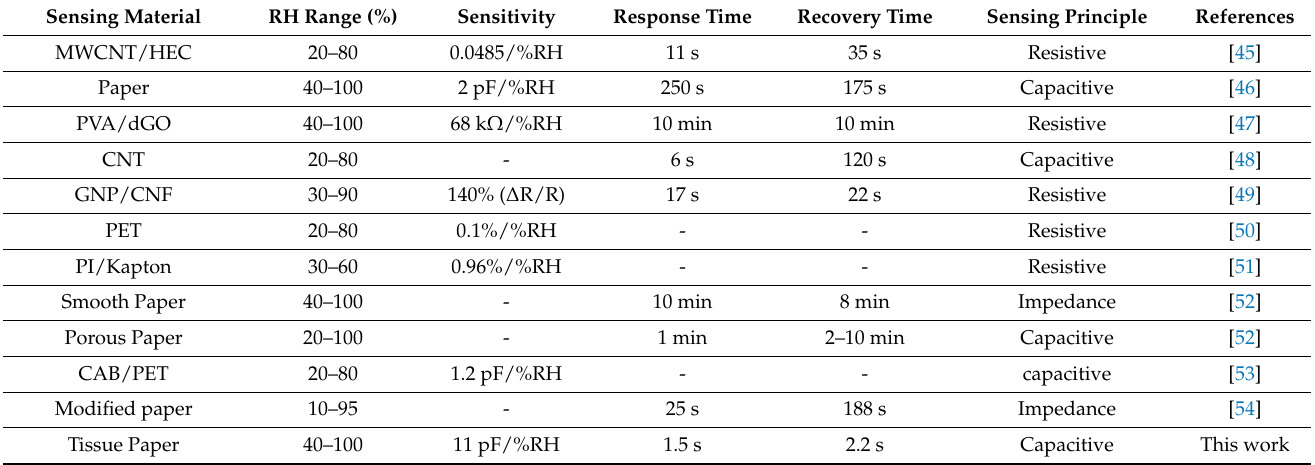
Figure 8. Capacitance of sensor versus %RH at inset temperatures. The comparison of the sensing parameters of our sensor, such as sensitivity, response time, and recovery time, with previously reported work is presented in Table 1. From the data presented in Table 1, it is clear that our proposed sensor exhibits remarkable results in terms of transient response and sensitivity. Table 1. Comparison of sensitivity, response time, and recovery time of different sensing materials with their sensing principles .